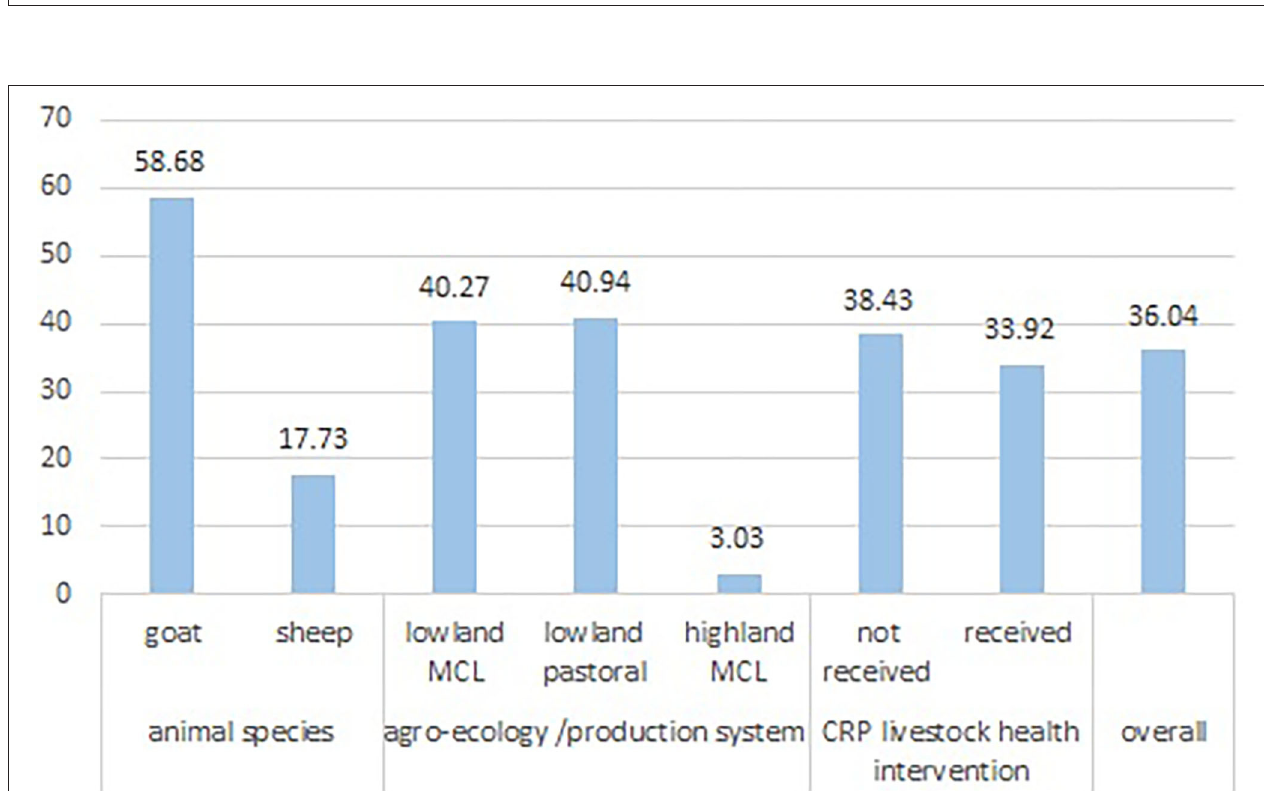
FIGURE 4 | Proportion of flock with abortion in sheep and goat in three agroecology and production system of Ethiopia.